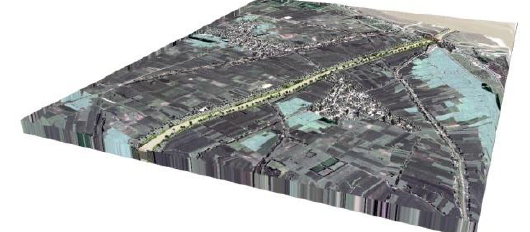
Fig.7a 3D panoramic virtual environment